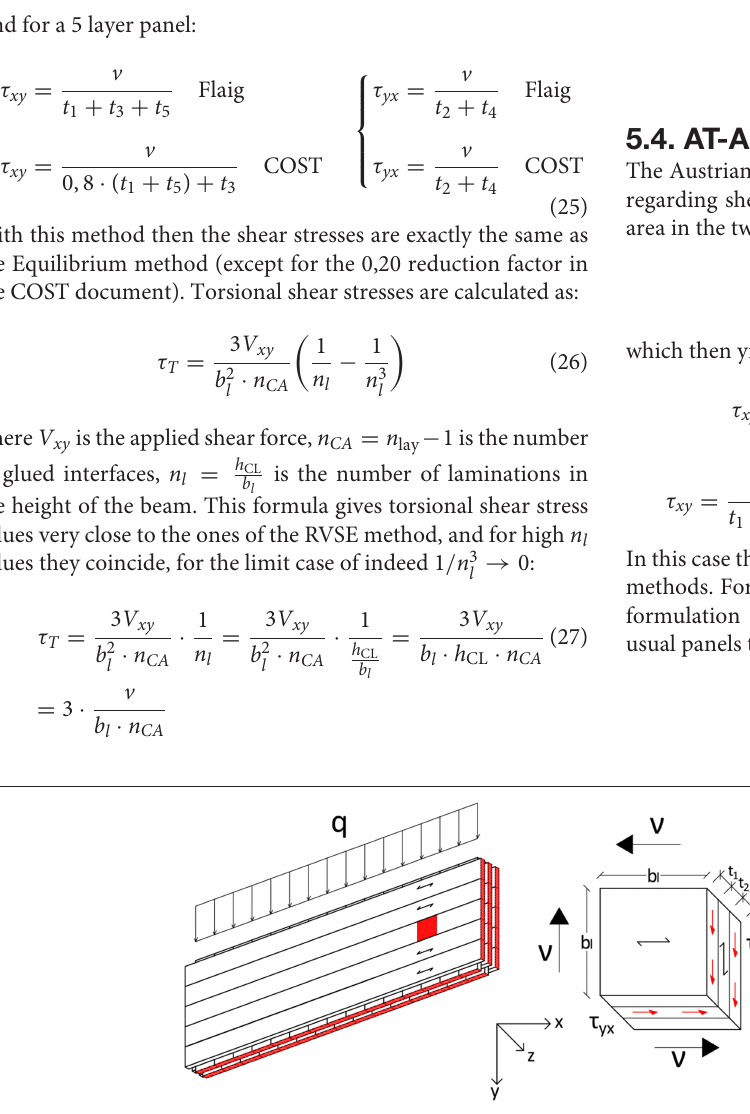
FIGURE 6 | Shear stresses for the beam method, on the right part a representative glue interface is shown.